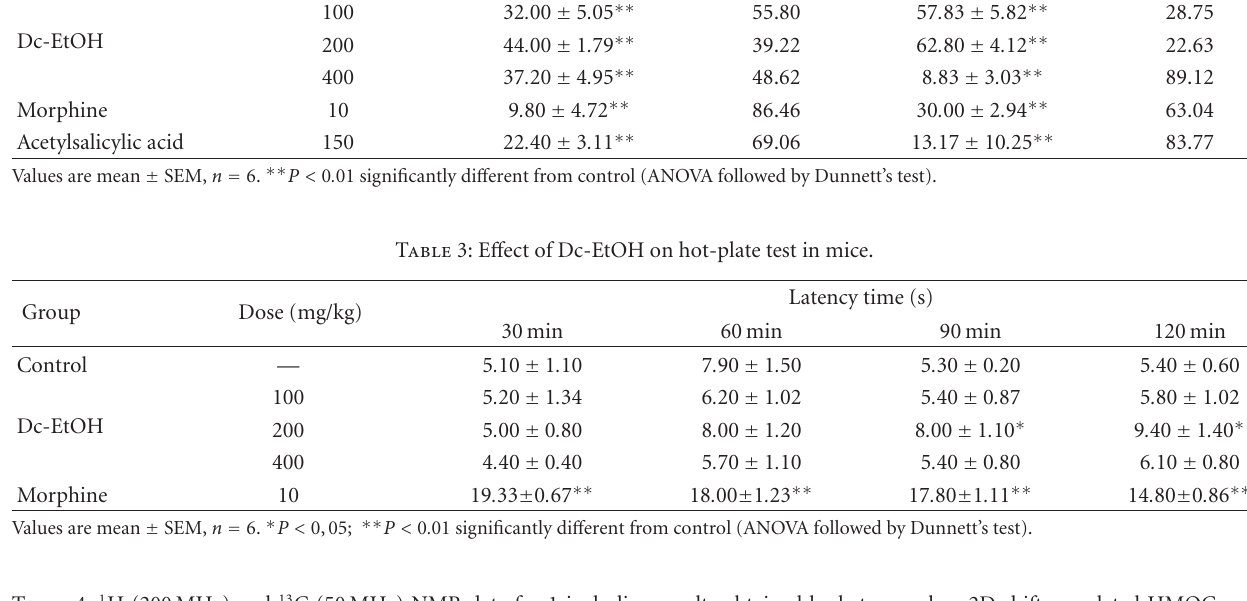
Table 4: 1 H (200 MHz) and 13 C (50MHz) NMR data for 1 including results obtained by heteronuclear 2D shift-correlated HMQC and HMBC spectra, in CDCl 3 as solvent and TMS as internal reference. Chemical shifts in δ (ppm) and coupling constants (J, in parenthesis) in